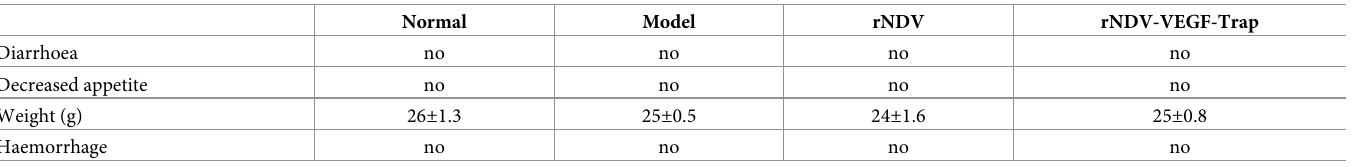
Data was presented from ten mice per group. no: No clinical symptoms were observed during the experimental